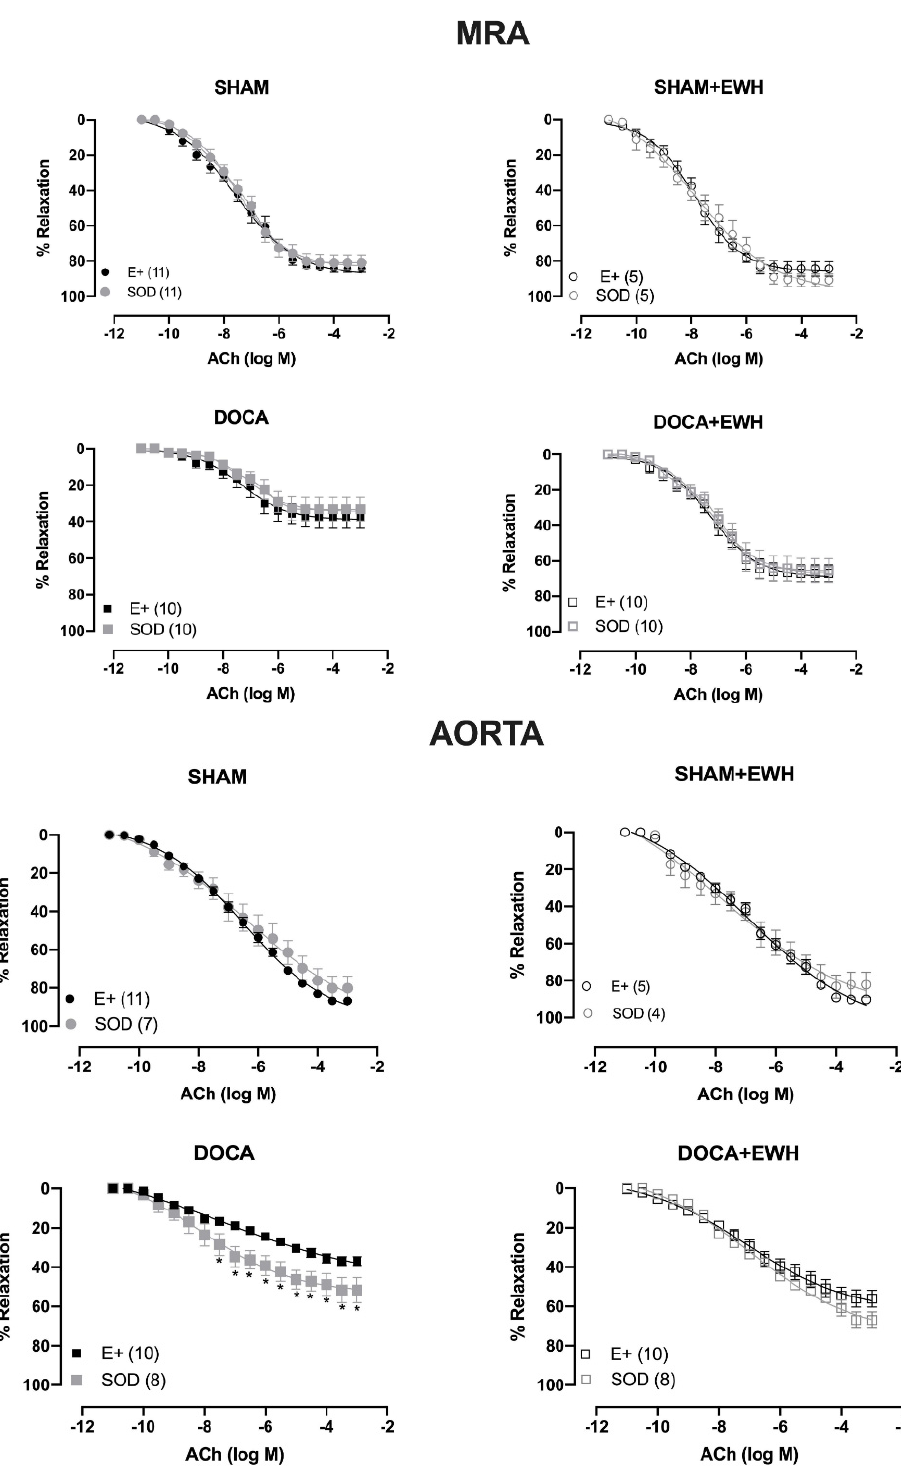
Figure 5. The role of EWH in ROS-mediated ACh-induced relaxation in MRA and aorta of DOCA-salt rats. Concentration–response curves to ACh were obtained in MRA (Upper graphics) and aorta (Bottom graphics) segments from rats from SHAM, SHAM+EWH, DOCA, and DOCA+EWH groups before (E+) and after incubation with scavenger reactive oxygen species, the superoxide dismutase (SOD, 750/mL). The results are expressed (mean ± SEM) as the percentage of relaxation responses in norepinephrine or phenylephrine precontracted rings. The number of animals in each group is in parentheses. Two-way ANOVA followed by Bonferroni post-test: p < 0.05 * vs. E+.